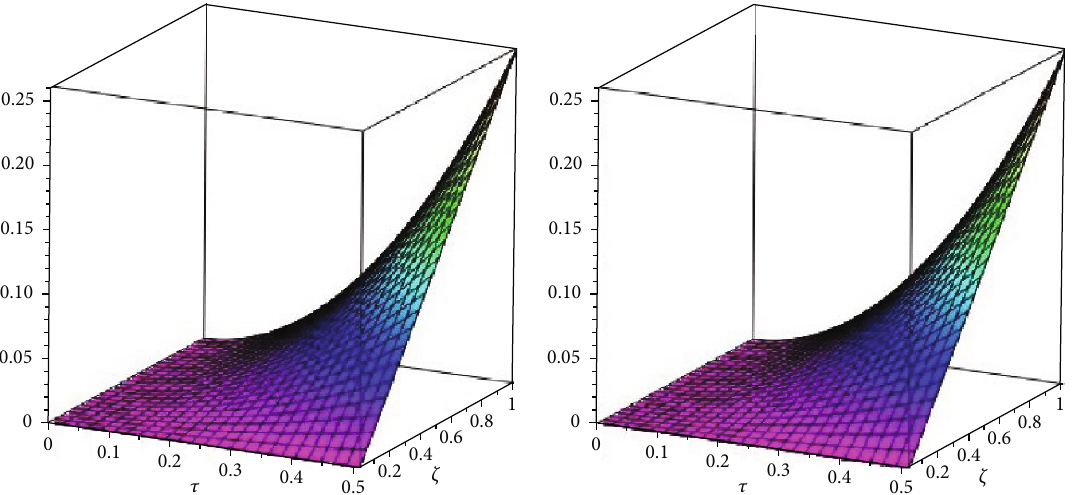
Figure 5: The exact and an approximate graph of problem